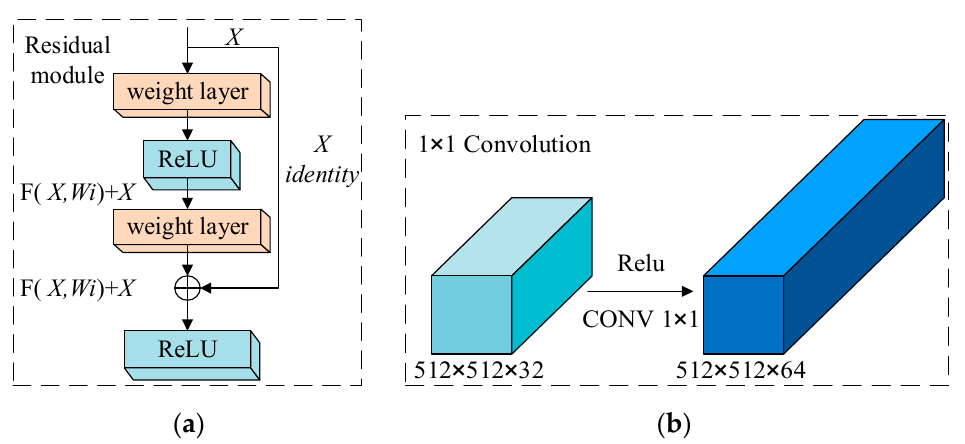
Figure 4. ( a ) Residual network module and ( b ) 1 × 1 convolution.